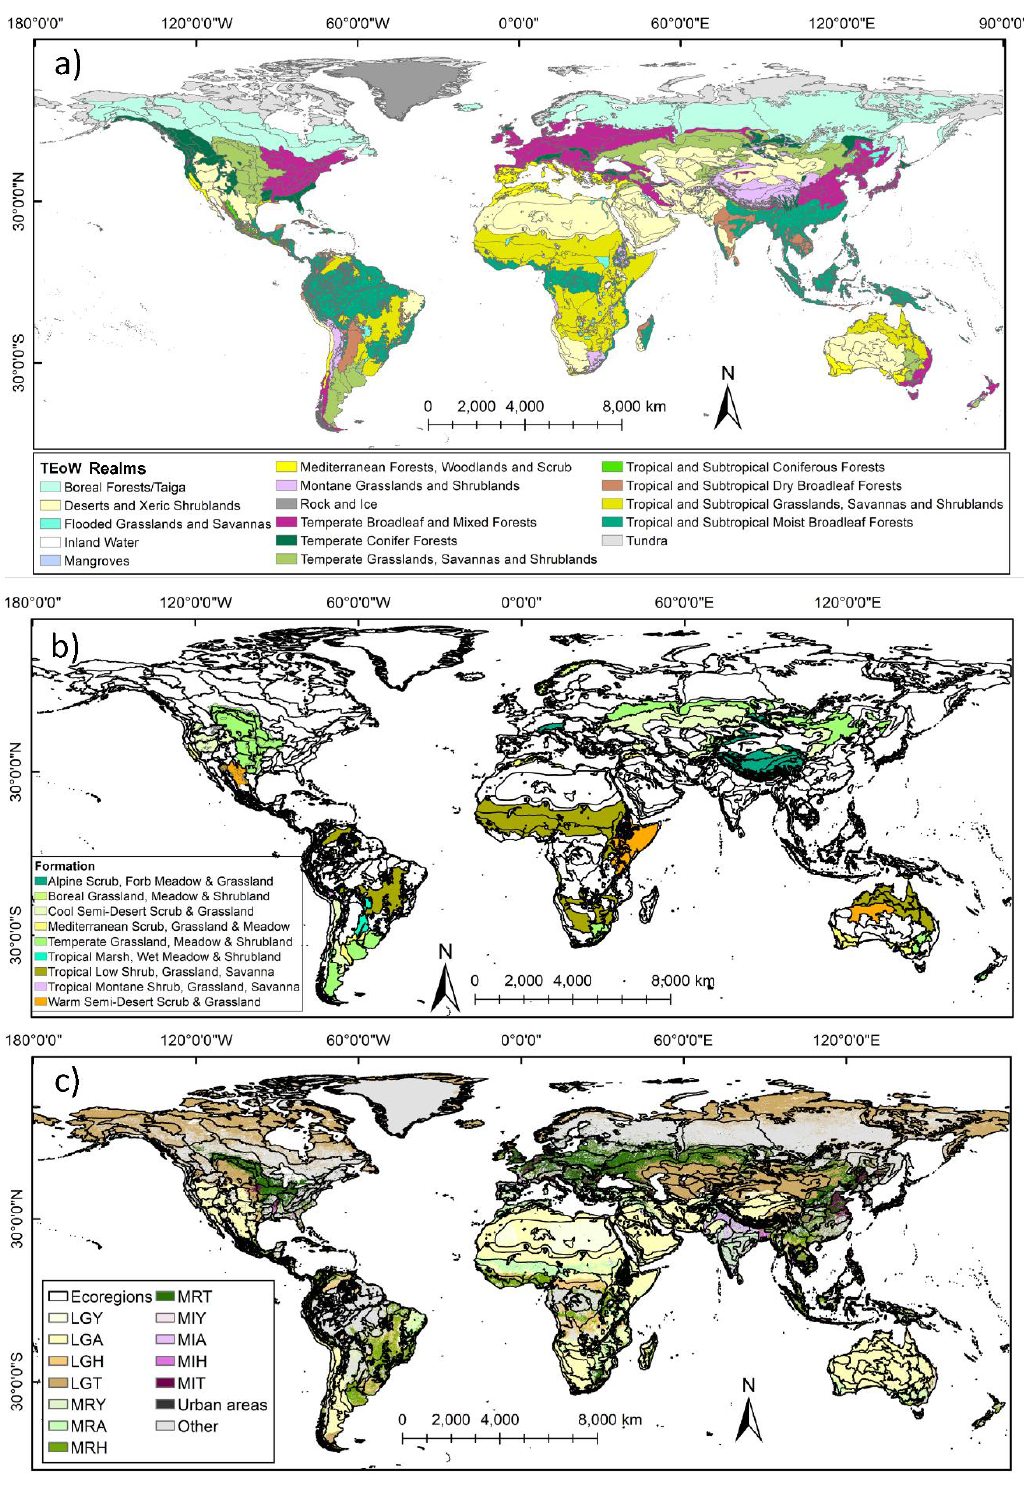
Figure 1. ( a ) Terrestrial Ecoregions of the World (TEoW) at Realm level. ( b ) World Grassland Type Ecoregions (WGT; legend shows formations). ( c ) Global Livestock Production Systems (GLPS). System codes as follows: Rangelands Hyper-arid (LGY); Rangelands Arid (LGA); Rangelands Humid (LGH); Rangelands Temperate (LGT); Mixed Rainfed Hyper-arid (MRY); Mixed Rainfed Arid (MRA); Mixed Rainfed Humid (MRH); Mixed Rainfed Temperate (MRT); Mixed Irrigated Hyper-arid (MIY); Mixed Irrigated Arid (MIA); Mixed Irrigated Humid (MIH); Mixed Irrigated Temperate (MIT).